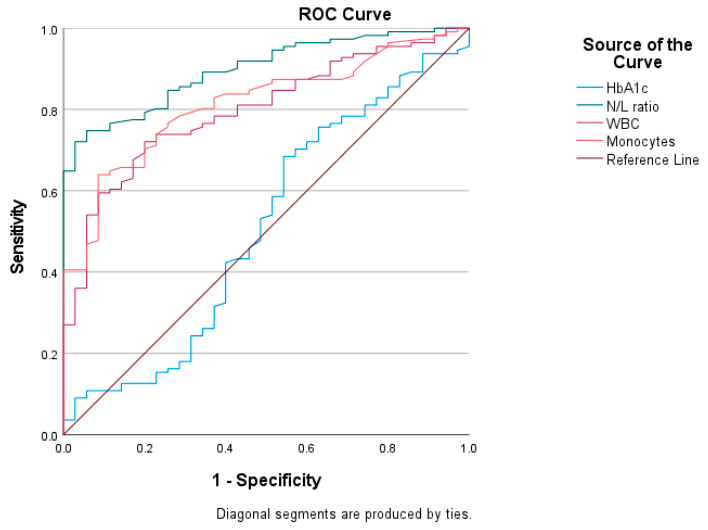
Figure 2. ROC curve analysis of HbA1c, WBCs, monocytes, and NLR; ROC, receiver operating characteristic. Significant differences were found ( p < 0.000, respectively, for NLR, WBCs, and monocytes).